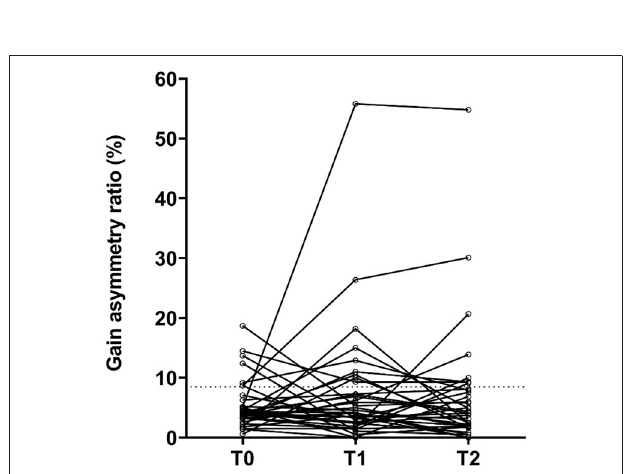
FIGURE 3 | Individual changes in vHIT gain asymmetry ratio (AR, %) ( n = 35). T0, baseline before implantation; T1, first postoperative follow-up; T2, second postoperative follow-up. Observations above the dotted line are considered abnormal (gain AR =